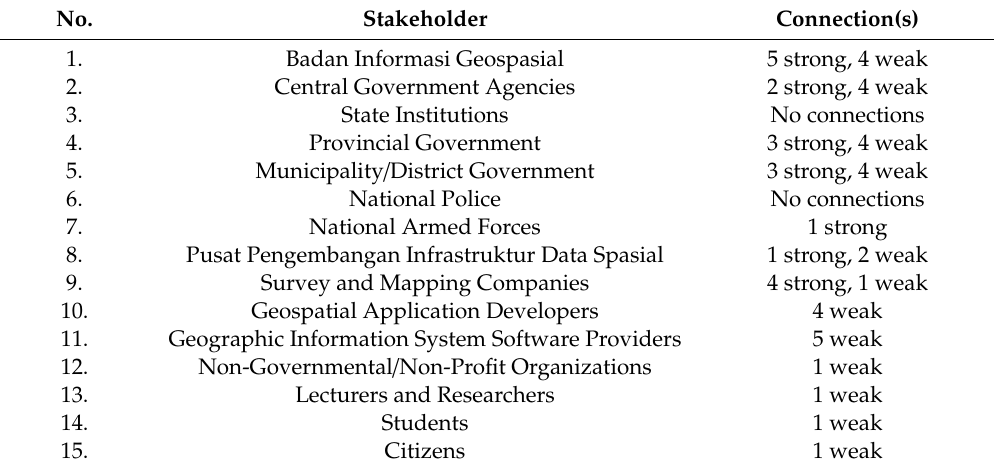
Table 3. Number of connections among national spatial data infrastructure